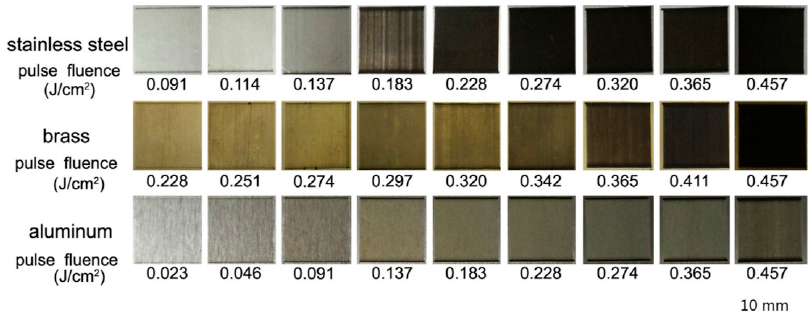
Figure 12. Optical images of metal surfaces (stainless steel, brass and aluminum) treated with fs-laser radiation at different pulse fluences. Reprinted from Ou et al . [89], Copyright 2016, with permission from Elsevier.